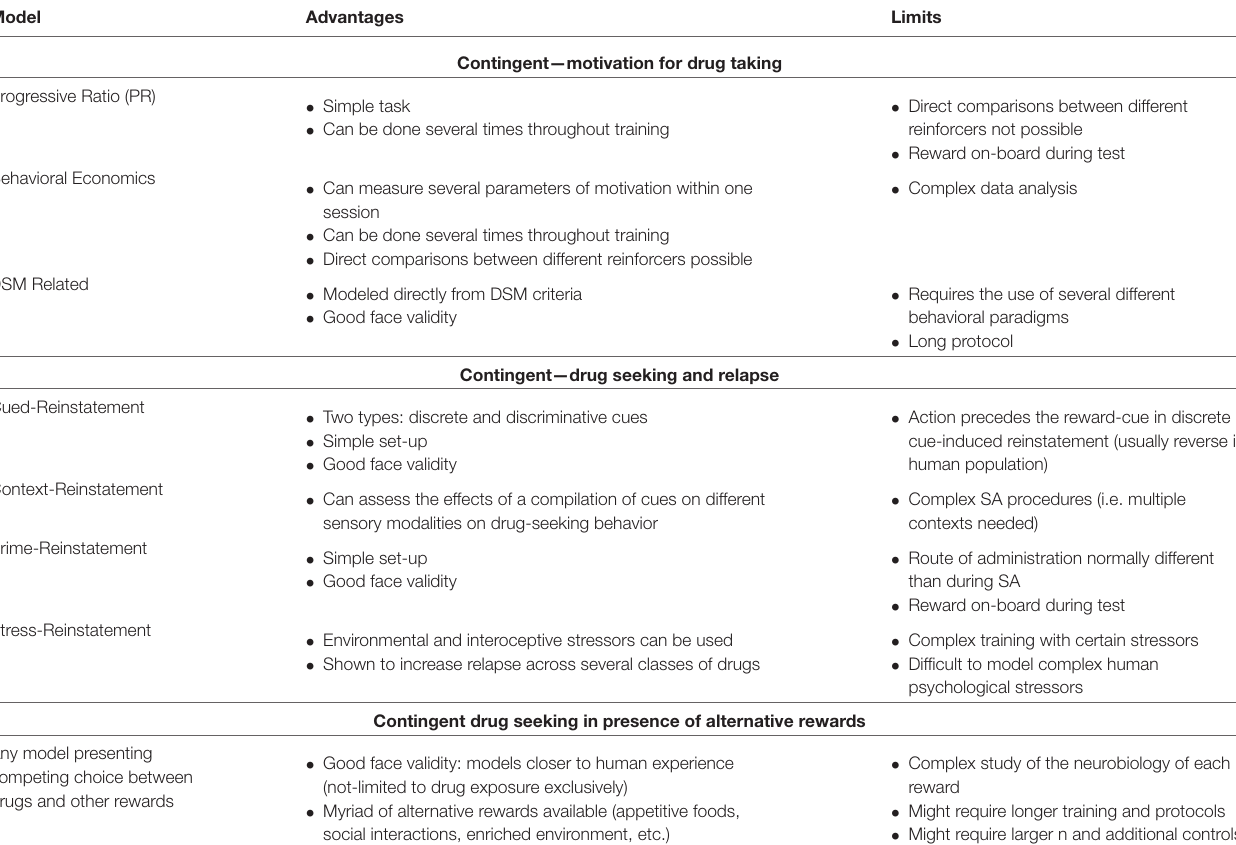
TABLE 2 | Brief summary of preclinical behavioral models most currently used to study the neurobiology of addiction: motivation and seeking in contingent models, models including alternative rewards. Model Advantages Limits Contingent—motivation for drug